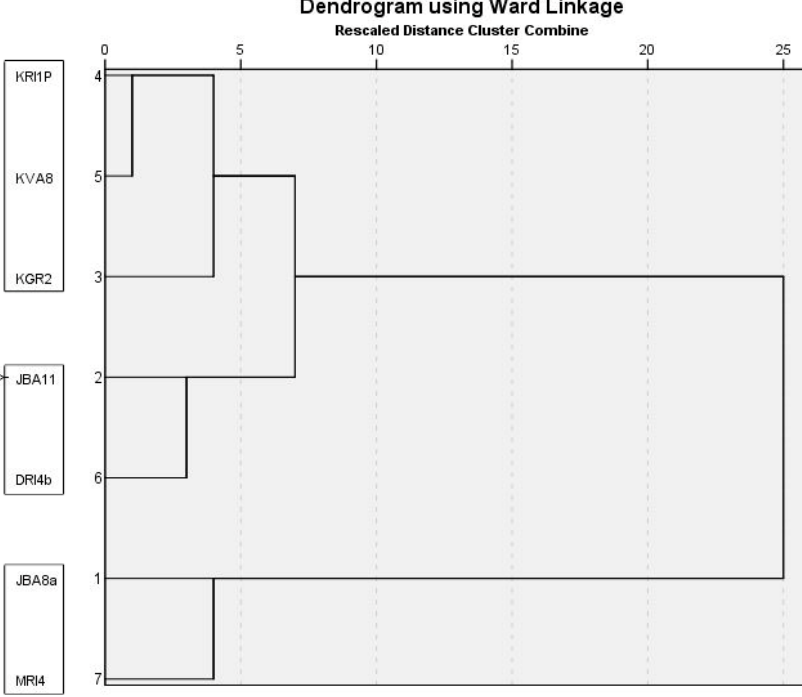
Figure 5. Dendogram showing grouping of Penicillium crustosum isolates based on colony diameter on different media (PDA, MEA, CYA, and YES), using Ward’s model with Euclidian Distance interval. P. crustosum isolates within a clade are indicated in black boxes.